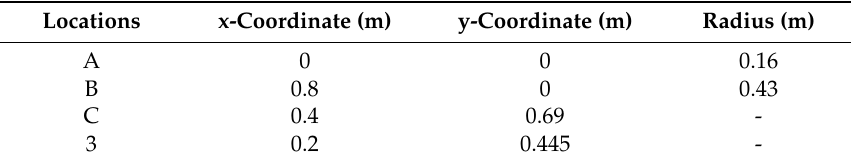
Table 6. Initial data of the third case